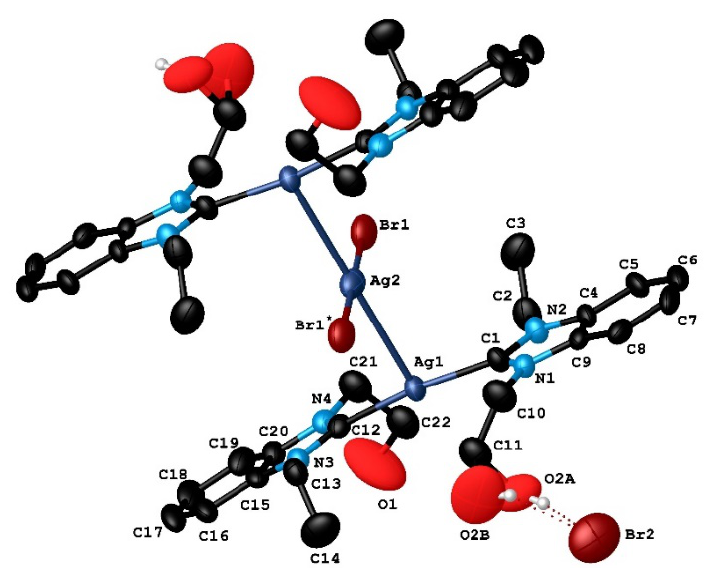
Figure 5. Molecular structure of Ag-NHC complex 1 with ellipsoids drawn at 30% probability level. Selected bond lengths (Å) and angles ( ◦ ): Ag1–Ag2 3.0966(7), Ag1–C1 2.098(7), Ag1–C12 2.096(8), Ag2–Br1